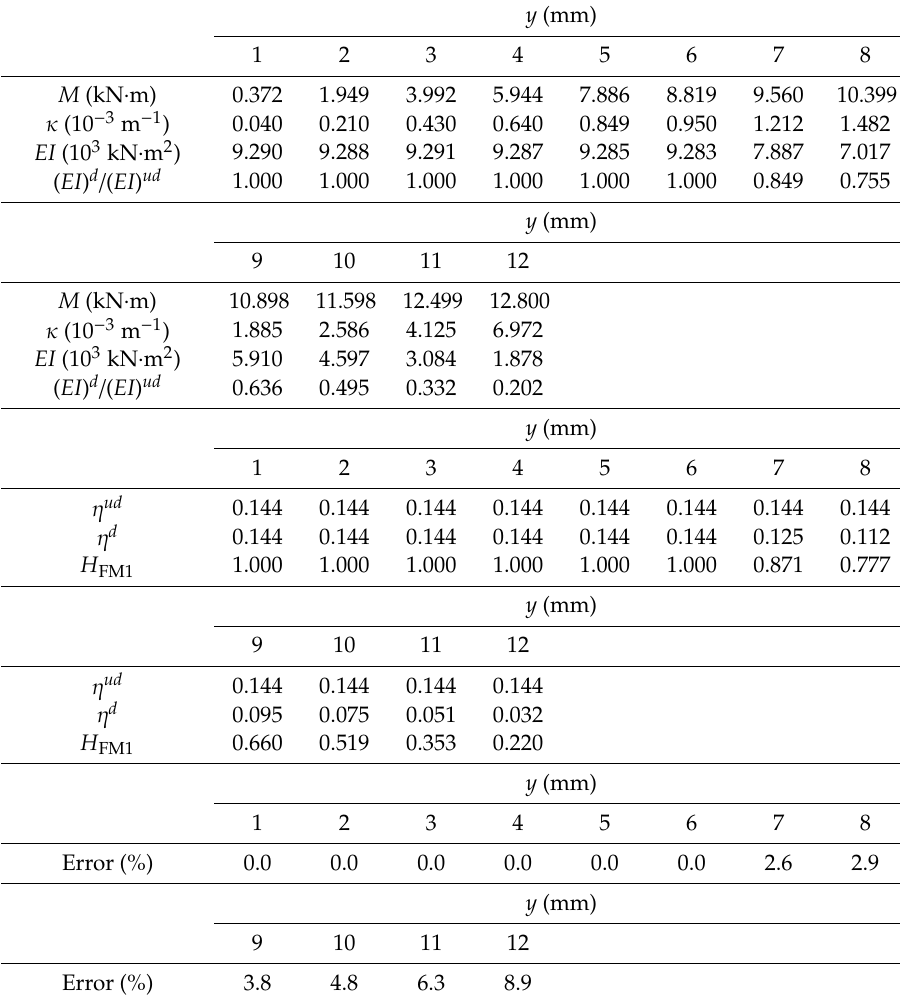
Table 18. Comparison between ( EI ) d / ( EI ) ud and H FM1 in E8.